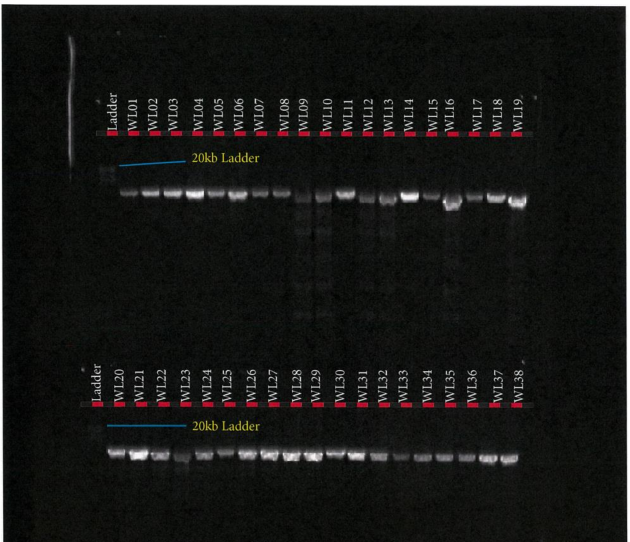
Figure 4. FASN fragment 3 PCR product in Tattykeel Australian White (WL), Poll Dorset (PD), and Texel (TX) lambs.